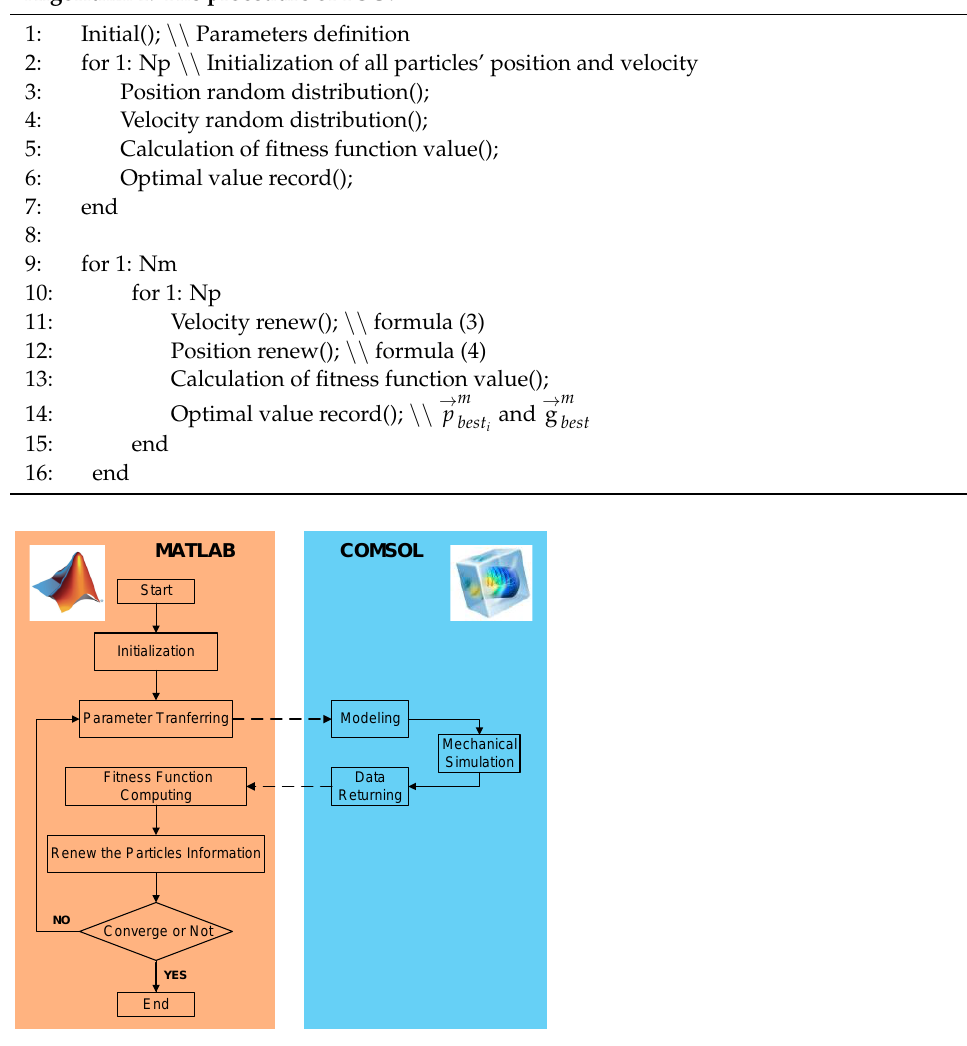
Algorithm 1: The procedure of PSO.